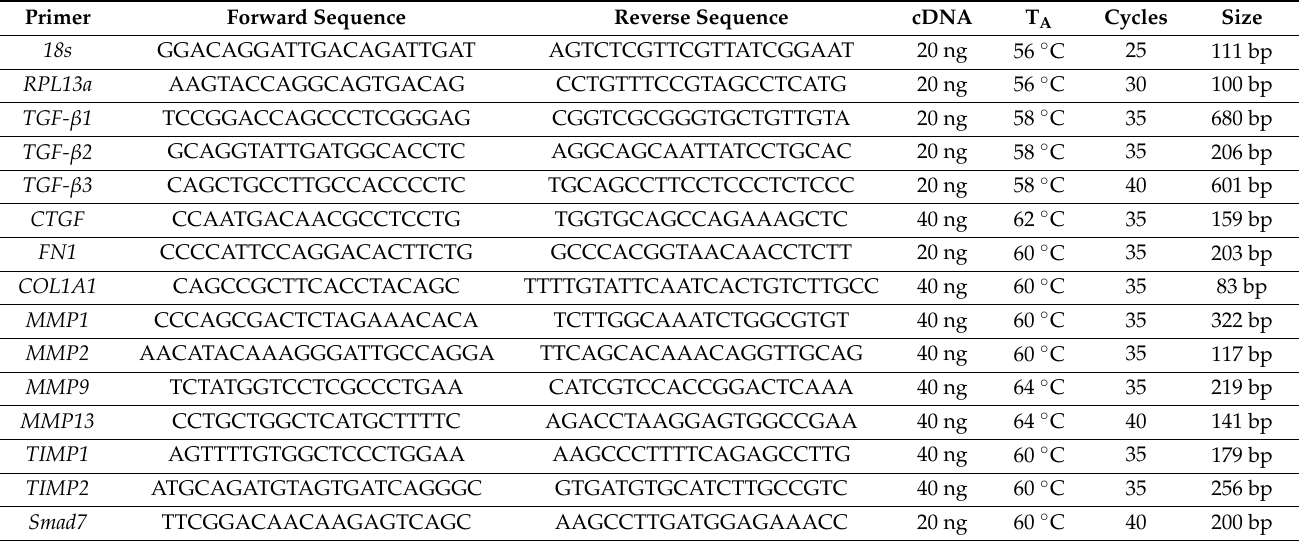
Table 1. Specificities of primers used for the analysis of gene expression with F: Forward and R: Reverse